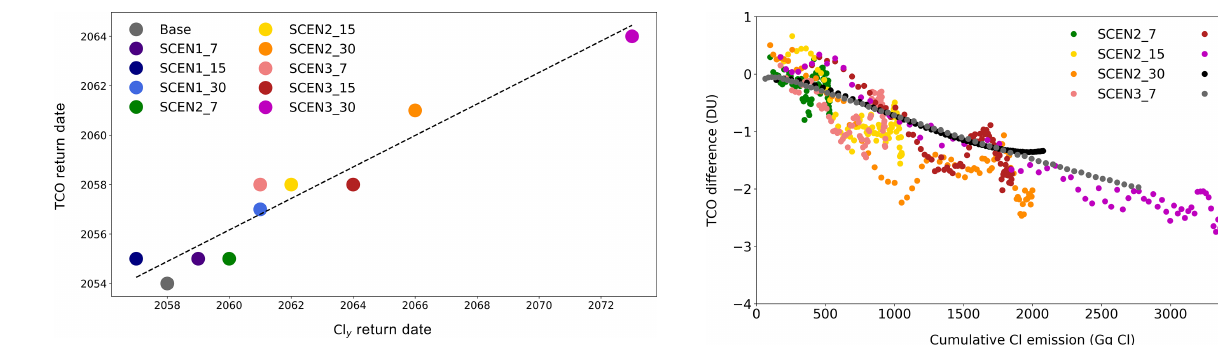
Figure 7. Annual mean TCO difference (in DU) for the UM-UKCA SCEN2 and SCEN3 simulations with respect to the BASE simula- tion, averaged over 60 ◦ S–60 ◦ N vs. cumulative emissions (Gg Cl) from 2012 to that year. Grey and black points show the same, but are for the CTM_Fix and CTM_Bank simulations performed with the TOMCAT CTM. For these simulations, TCO differences are cal- culated with respect to the CTM_C baseline simulation. TOMCAT simulations described in Dhomse et al.